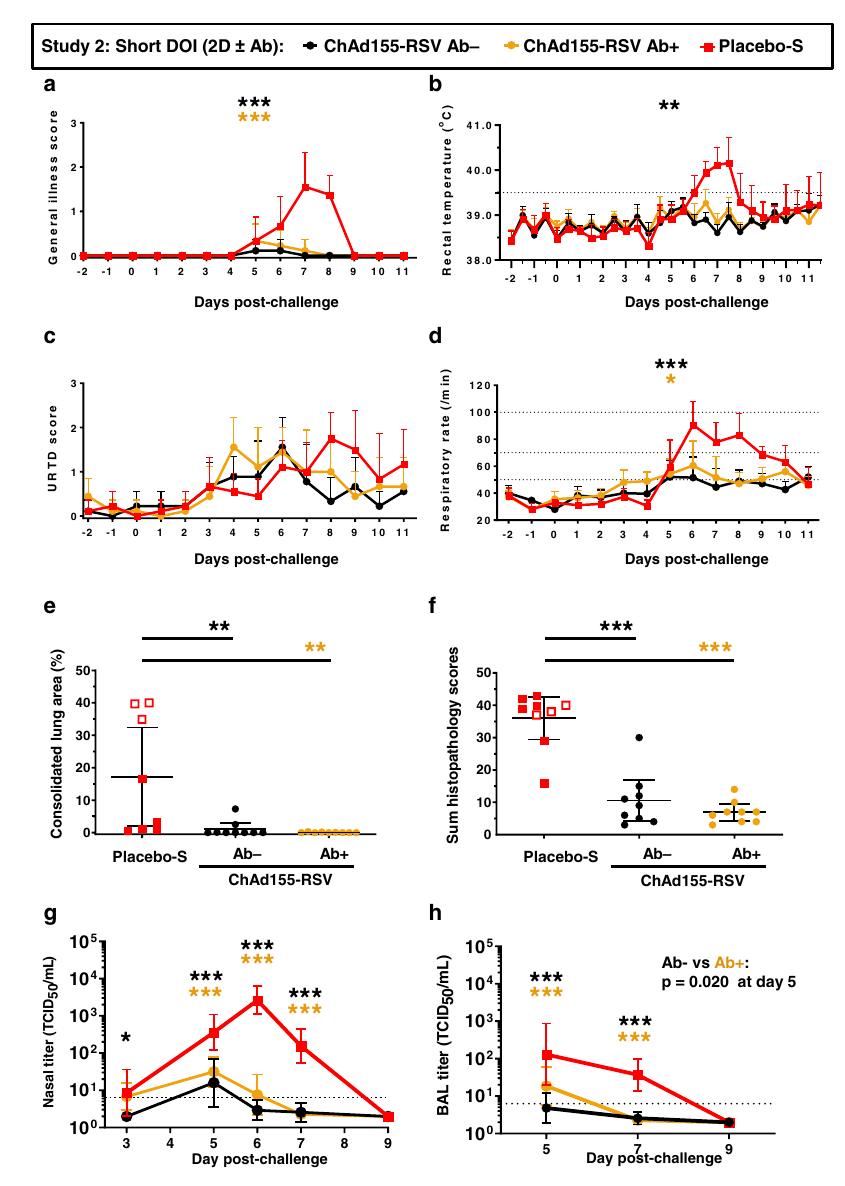
Fig. 5 | Impact of pre-existing bRSV Ab on ChAd155-RSV vaccine ef fi cacy. In Study 2, calves ( n =9 biologically independent animals, see Table 1) with (Ab+) or without (Ab − ) pre-existing antibodies derived from bovine RSV Ab+ or Ab − colos- trum, received two doses (2D) of ChAd155-RSV or placebo, and were challenged afterashort(4weeks)durationofimmunity(DOI).Ondaypost-challenge(dpc)12/ 13,animals were subjectedto necropsy. The placebo-S group indicates the control group,whichincluded9calvesthroughdpc7,decreasingto8calvesondpc8,and then to 6 calves on dpc 9 to 11 (as the other calves were pre-terminated due to reaching humane endpoints). Analyzed were general illness scores ( a ), rectal temperatures ( b ), upper respiratory tract disease (URTD) scores, ( c ), respiratory rates ( d ), consolidated lung areas (CLAs; e ), lung pathological changes at termi- nation time point ( f ), and nasopharyngeal and lung viral loads ( g , h , respectively;